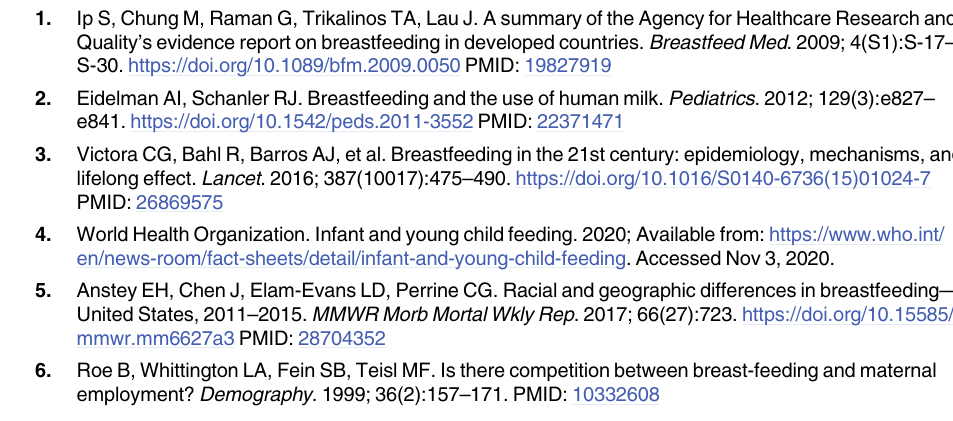
S1 Table. Full set of multivariate models predicting breastfeeding duration and non-initia- tion by mother’s race and employment status/occupation type. S2 Table. Predicted breastfeeding duration based on mother’s employment status/occupa- tion type and race. S3 Table. Sensitivity analyses to assess effects of clustering among siblings born to same